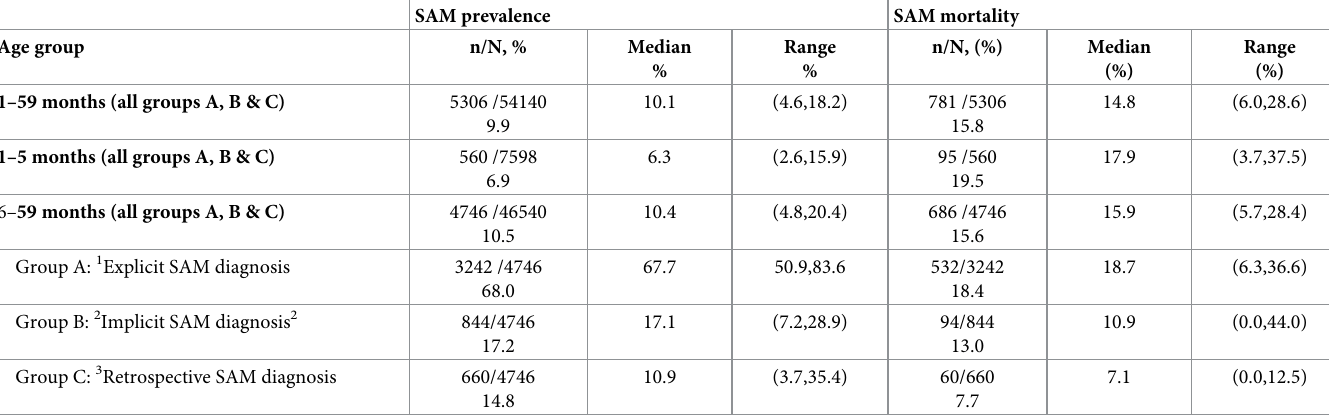
Table 2. Prevalence and mortality according to age among children admitted with severe acute malnutrition in clinical information network